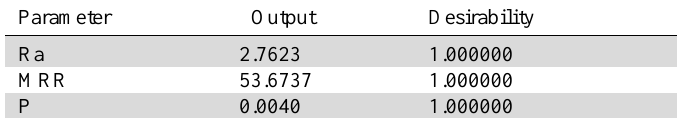
Global Solution Predicted